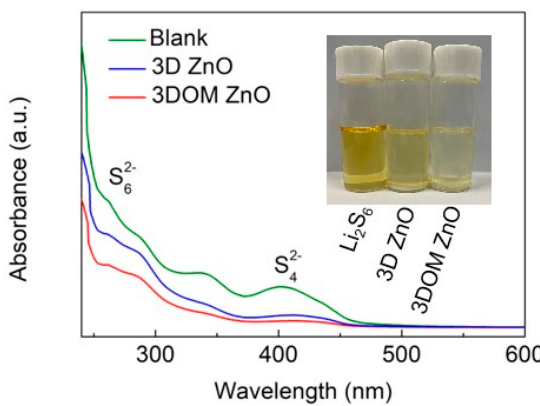
Figure 4. UV-vis spectra and optical images (inset) of Li 2 S 6 solution before and after adsorption by 3DOM ZnO and 3D ZnO.